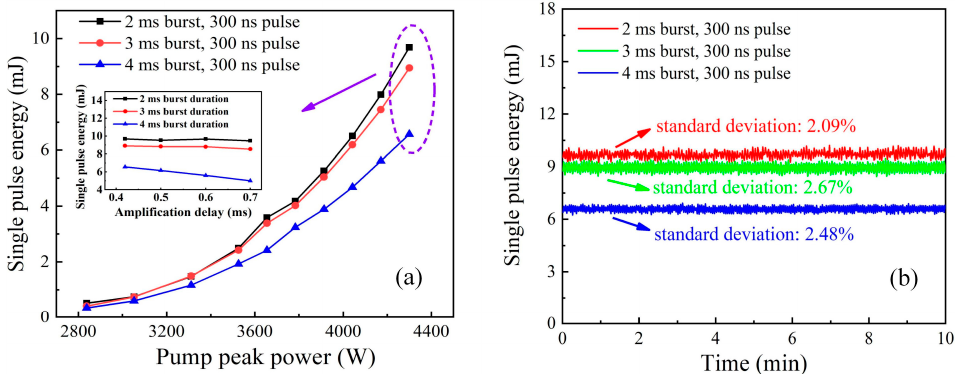
Figure 7. ( a ) Output pulse energy versus input pump peak power at amplification delay of 0.42 ms (Inset: amplified delay versus pulse energy for flat-top envelope and pulse profile at full pump energy); ( b ) Corresponding operation stability of pulse burst MOPA laser system for uniform envelope distribution at flat-top pulse profile.